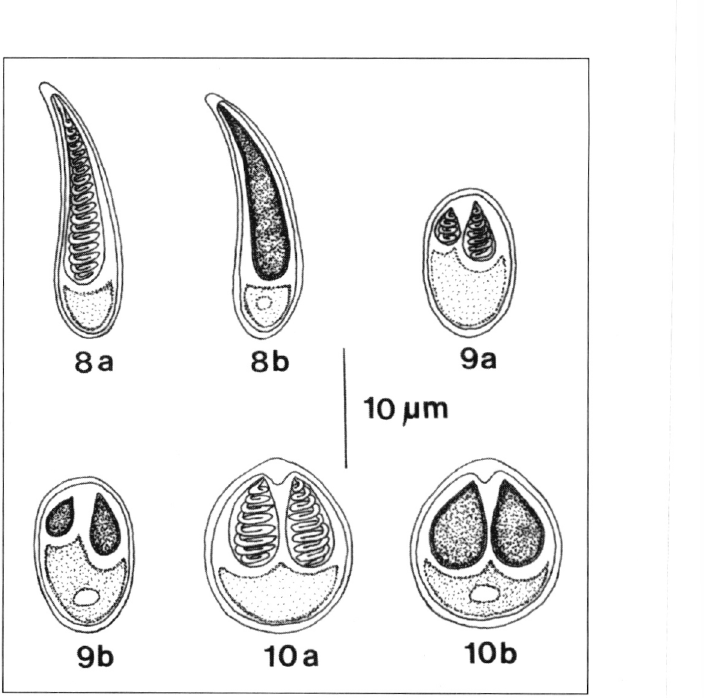
Figs 8-10. - Spores des myxosporidies étudiées (échelle : 10 µ m). 8. Thelohanellus taguii n. sp. a) noter la forme générale de la spore et le nombre de spires du filament au sein de la capsule polaire, b) le sporoplasme contient une petite vacuole iodophile. 9. Myxobolus mbailaoi n. sp. a) les capsules polaires sont d’inégales dimensions, b) le sporoplasme est développé et contient une vacuole